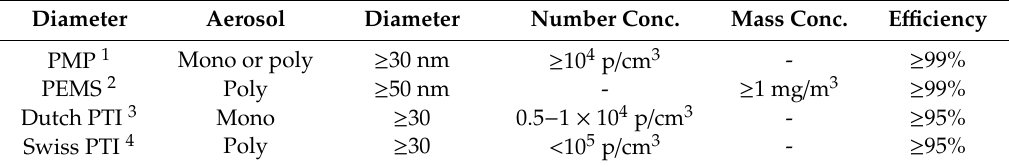
Table 5. Volatile removal e ffi ciency requirements of tetracontane particles for various systems. Diameter Aerosol Diameter Number Conc. Mass